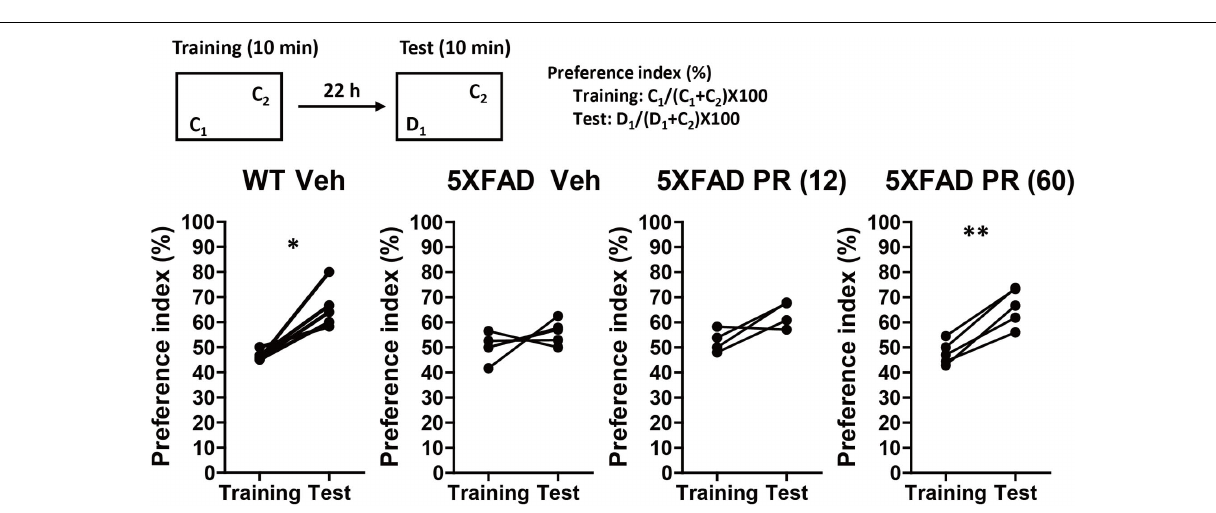
FIGURE 2 | Effects of Polygalae Radix (PR) extract on memory deficits in 5XFAD mice. Vehicle solution (Veh) or PR extract [at doses of 12 or 60 mg kg − 1 day − 1 ; PR (12), PR (60), respectively] were orally administered daily for 56 days to 4-month-old WT or 5XFAD mice. A novel object recognition test was performed the day after the last administration. Preference indices of objects C 1 (training session) and D 1 (test session) were quantified. The values of preference indices of each mouse are shown. ∗ P < 0.05, ∗∗ P < 0.01; paired t -test, n = 4–5